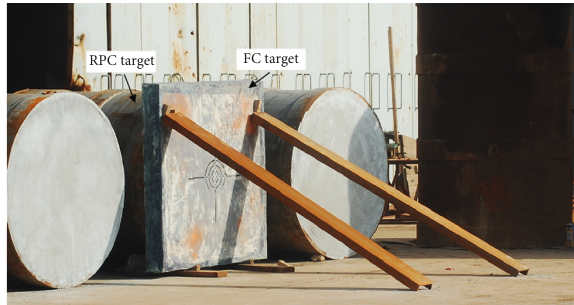
Figure 3: FC-RPC composite target.